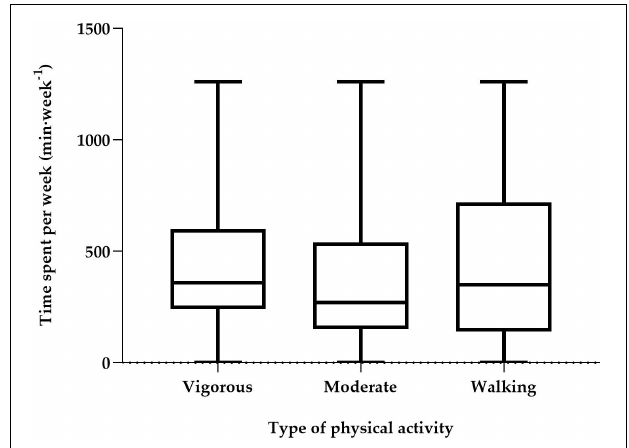
FIGURE 1 | Time spent per week (min · week - 1 ) with physical activities, presented by type of physical activity, based on IPAQ-SF. Values are median and interquartile